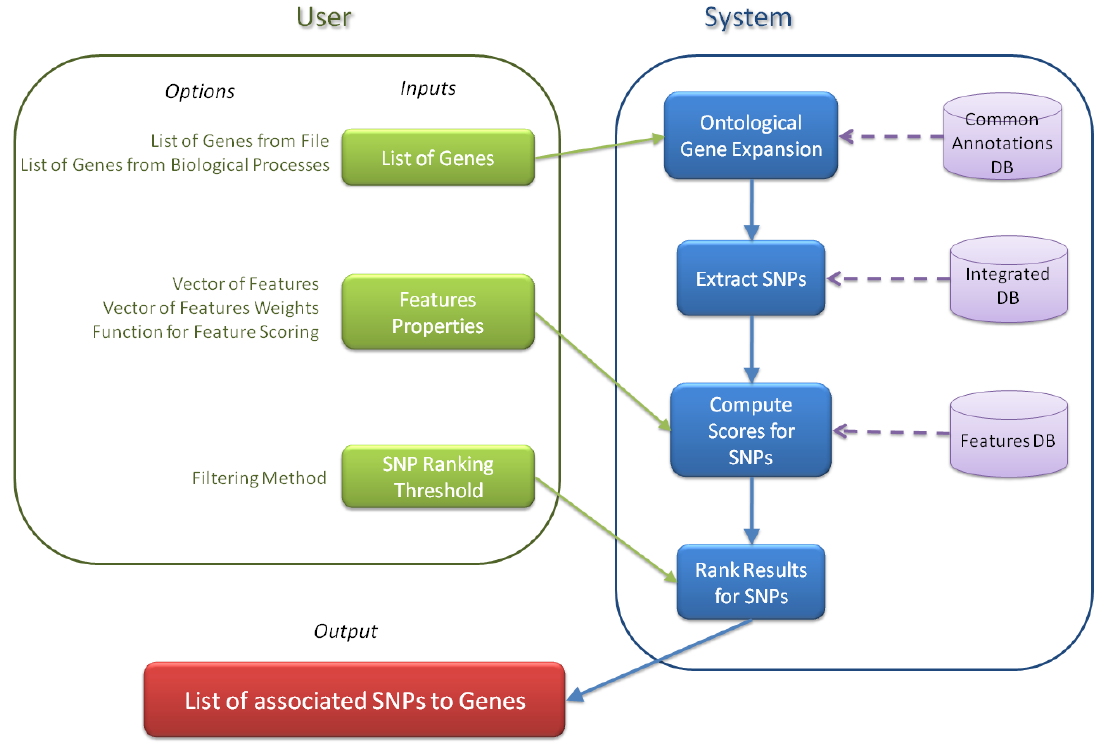
Figure 1: General schema of the